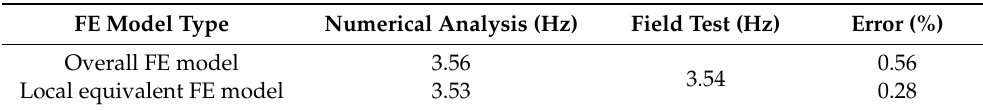
Table 2. Comparison of the fundamental frequencies of the second-story suspended floor obtained by numerical analysis and field